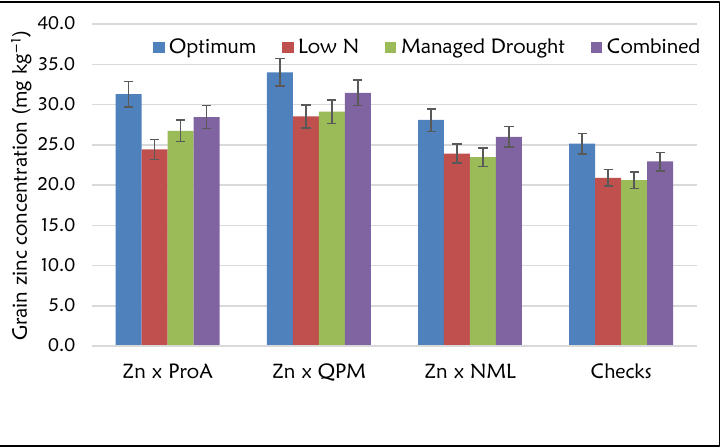
Figure 3. Grain zinc concentration (mg kg − 1 ) for the Zn-enhanced normal (Zn × NML), provitamin A (Zn × ProA) and QPM (Zn × QPM) testcross hybrids and checks evaluated under stress and non-stress environments.